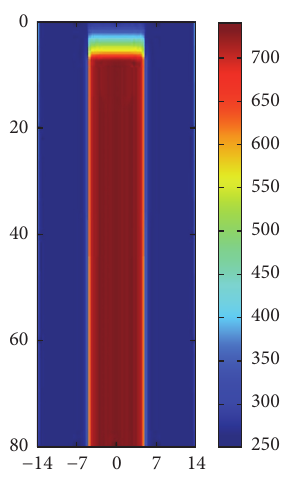
Figure 10: Temperature field of the target area (considering the axial heat